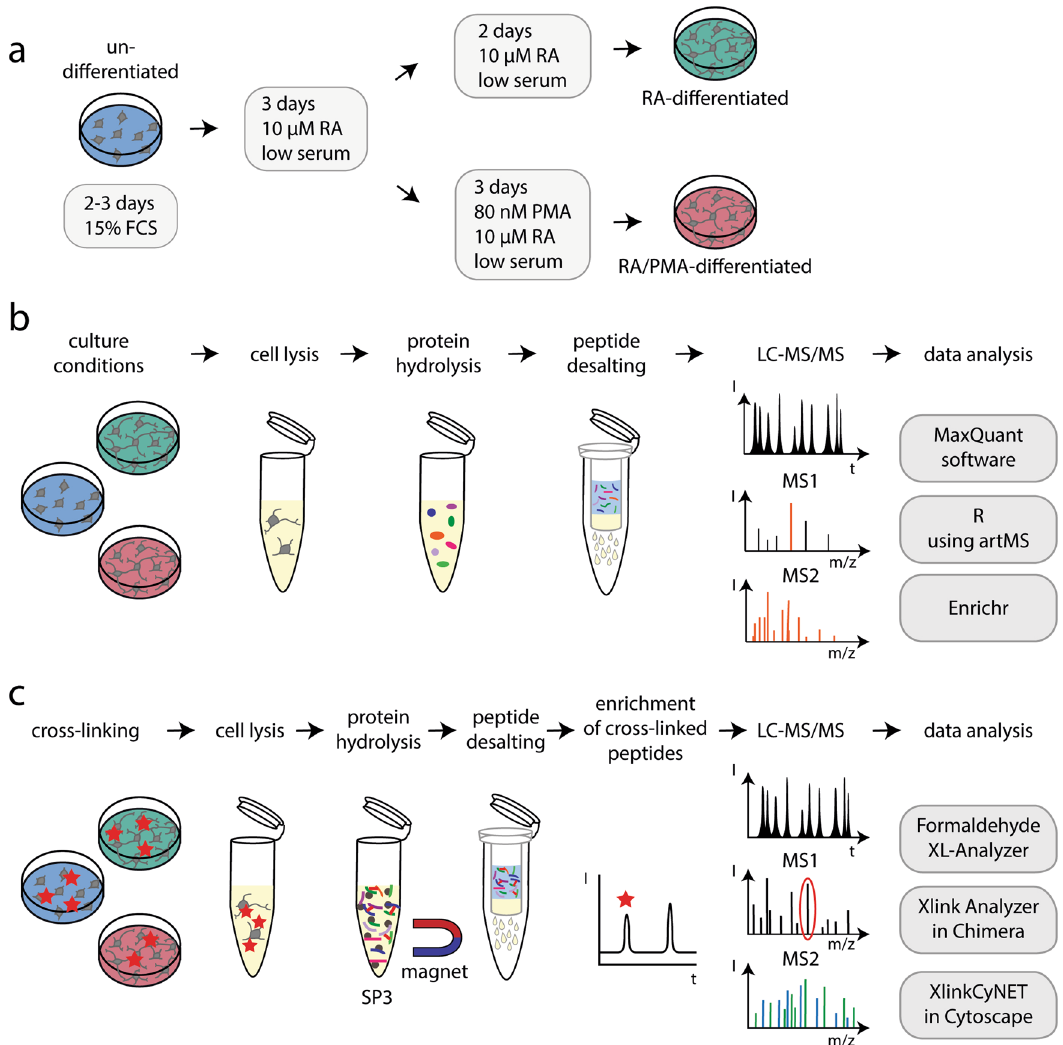
Fig. 1 Work fl ow for differentiation as well as proteome and cross-linking analysis of SH-SY5Y cells. a SH-SY5Y cells were passaged every 2 – 3 days and then differentiated using RA or a combination of RA and PMA (RA/PMA). See Methods section for details. b Work fl ow for proteome analysis of SH-SY5Y cells. After cell lysis, the proteins were hydrolysed and peptides were prepared for MS analysis. The peptides were analysed by LC-MS/MS followed by data analysis. See Methods section for details. c Proteins of SH-SY5Y cells were cross-linked with formaldehyde. After cell lysis, the proteins were hydrolysed, cross-linked peptide pairs were enriched and prepared for MS analysis followed by LC-MS/MS and data analysis. See Methods section for